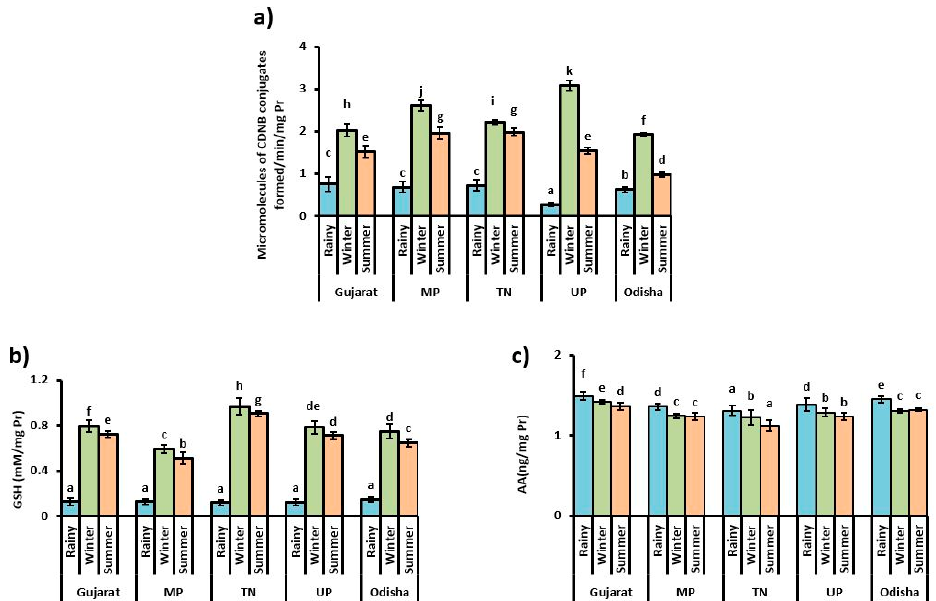
Figure 3. Seasonal variation in bio-transferring enzyme activity and content of small redox regulatory molecule in P. globosa . ( a ) glutathione-S-transferase, ( b ) non-protein-SH, ( c ) ascorbic acid. The data represent mean ± SEM with superscripts indicating statistical differences between mean values at the p < 0.05 level.